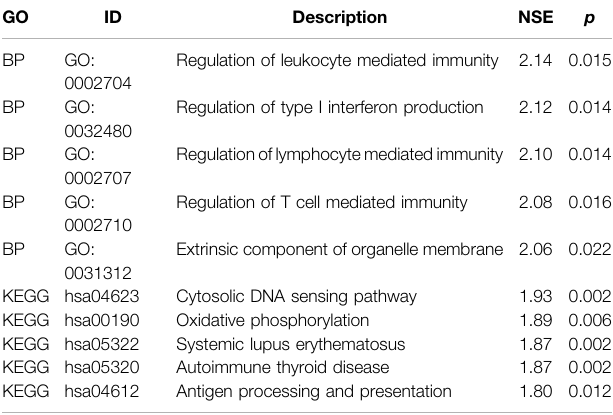
TABLE5| Signi fi